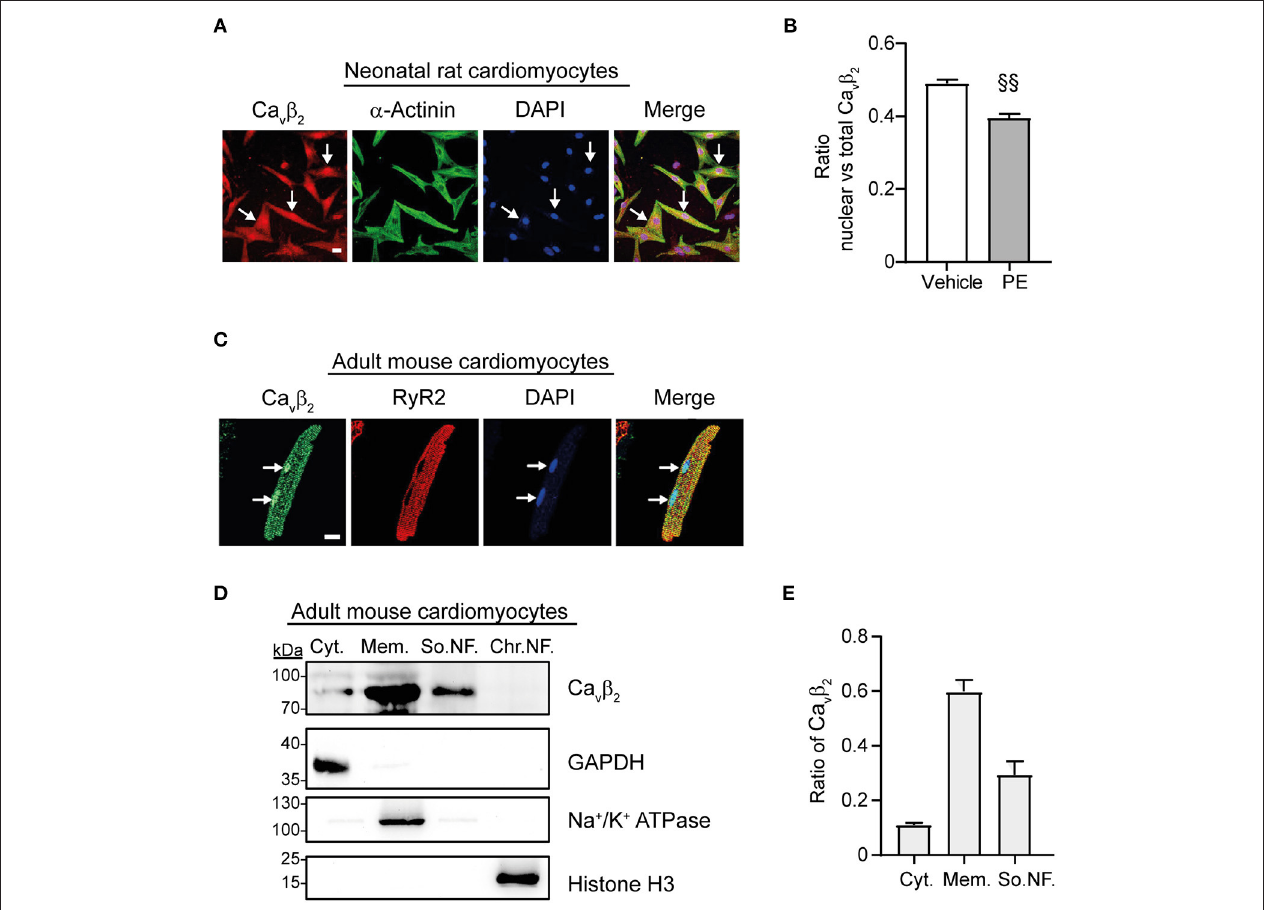
FIGURE 3 | A fraction of Ca v β 2 locates in the nucleus in neonatal and adult cardiomyocytes. (A) Confocal fluorescence images of representative NRCs showing a fraction of Ca v β 2 located in the nucleus (indicated with white arrows). Cells were fixed and stained for Ca v β 2 (red), α -actinin (green) and nucleus (DAPI, blue). Scale bar represents 15 µ m. (B) Bar plot of the Manders coefficient colocalization analyses between Ca v β 2 and DAPI nuclear staining in NRCs after treatment with vehicle or 50 µ M phenylephrine (PE). Mean ± SEM; 150–200 cells from 20 randomly chosen fields and from 3 replicated experiments were measured; §§ p < 0.01 (two-tailed unpaired t -test). (C) Confocal fluorescence images of a representative adult mouse cardiomyocyte showing a fraction of Ca v β 2 located in the nucleus (indicated with white arrows). Cells were stained for Ca v β 2 (green), ryanodine receptor 2 (RyR2, red) and nucleus (DAPI, blue). Scale bar represents 15 µ m. (D) Western blots of subcellular fractions from adult mouse cardiomyocytes. Cytosolic fraction (Cyt.), membrane fraction (Mem.), soluble nuclear fraction (So.NF.) and chromatin